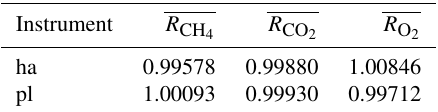
Table B1. Calibration factors for ha and pl to match hb, for X CH X CO , and oxygen column number density measurements, deter- 2 mined using GFIT